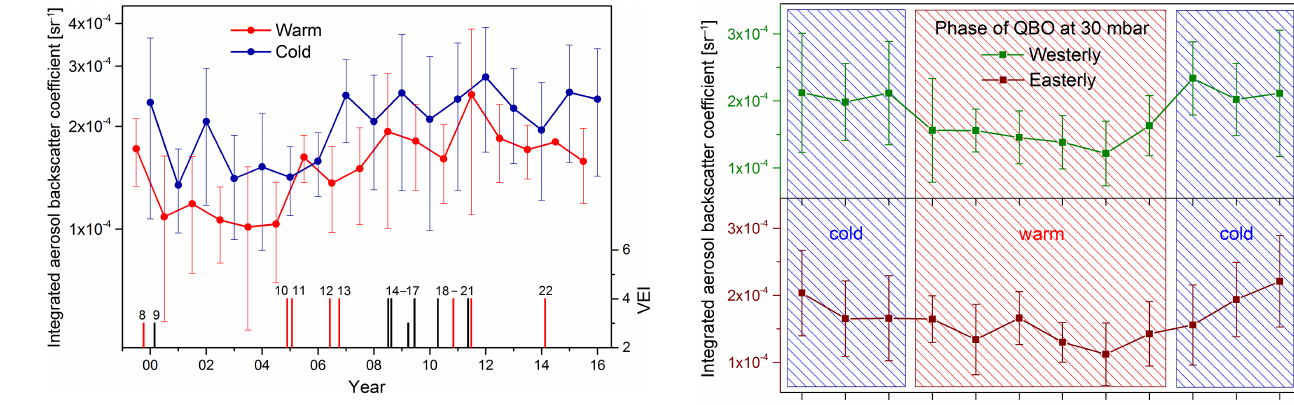
Figure 2. Interannual variations of B a π values (in the stratosphere over Tomsk) separately averaged over the warm and cold half years. The warm and cold average points are assigned to 1 June of the cur- rent year and 1 January of the next year, respectively. Black and red vertical bars at the bottom of the figure indicate volcanic eruptions as in Fig. 1 (see also Table 1). All error bars represent the standard deviation.